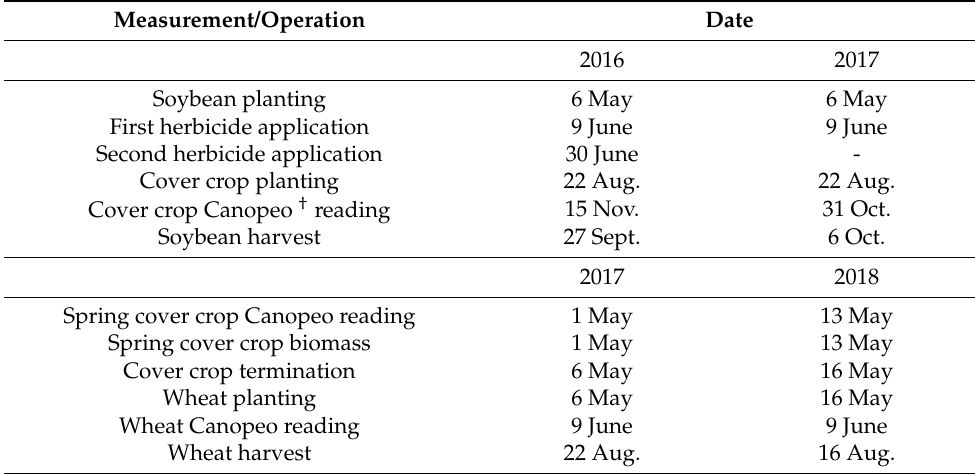
Table 2. Dates of important measurements and field operations between 2016 and 2018 at Fargo, ND,